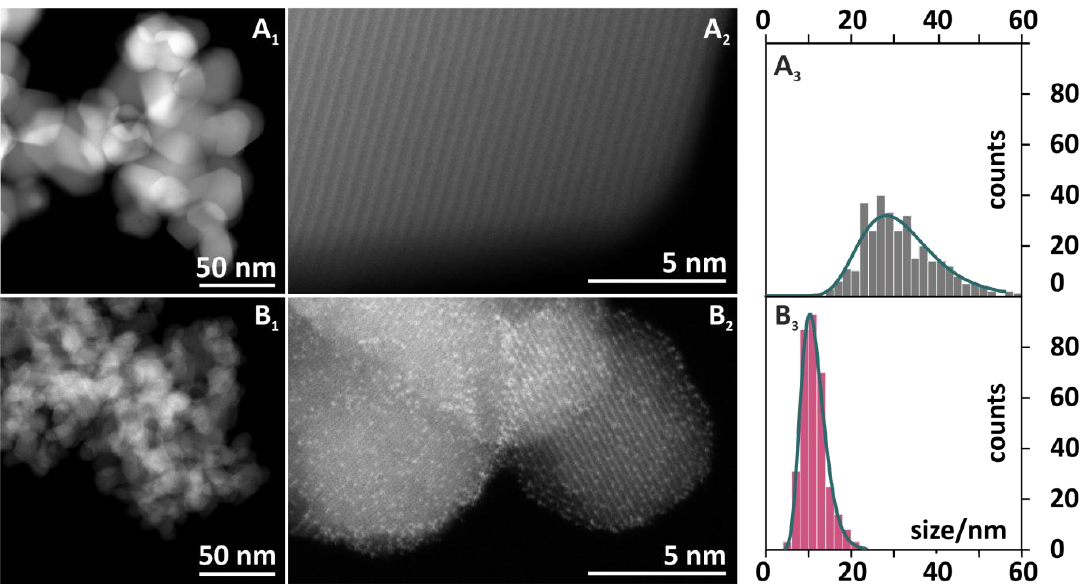
Figure 5. High-angle annular dark-field scanning transmission electron microscopy (HAADF-STEM) images of the Co 3 O 4 ( A 1 , A 2 ) and 6.6 wt % Bi-Co 3 O 4 ( B 1 , B 2 ) catalysts with the distributions of nanoparticles size ( A 3 and B 3 , respectively). Histograms are based on n = 350 measurements of individual crystallites.